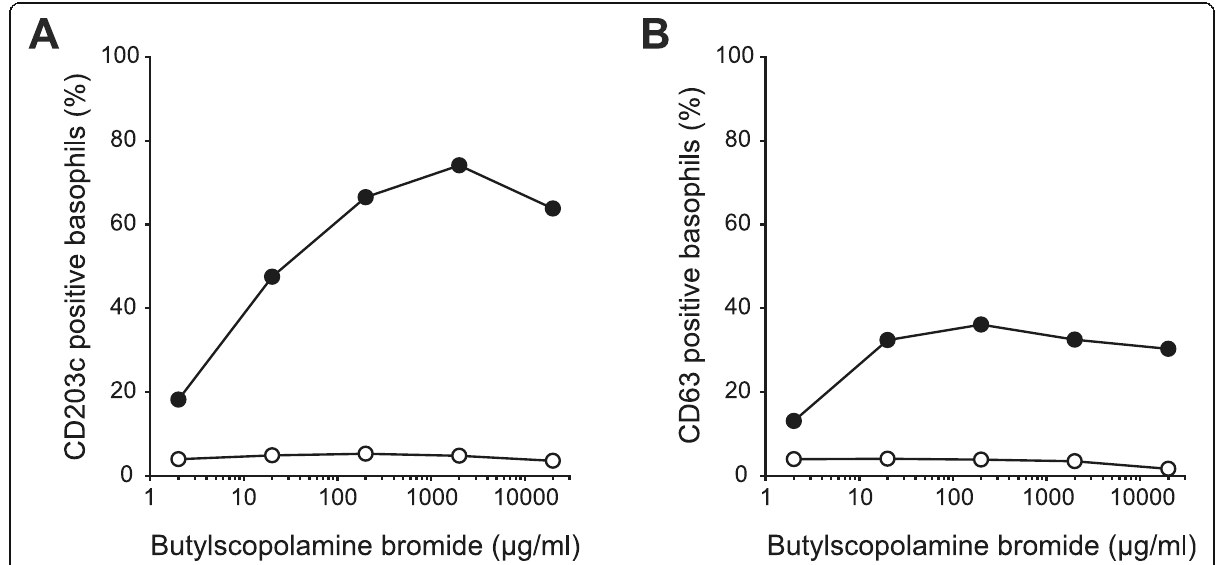
Fig. 1 CD203c ( a ) and CD63 ( b ) upregulation in a patient with butylscopolamine bromide-induced anaphylaxis (closed circles) and a control individual (open